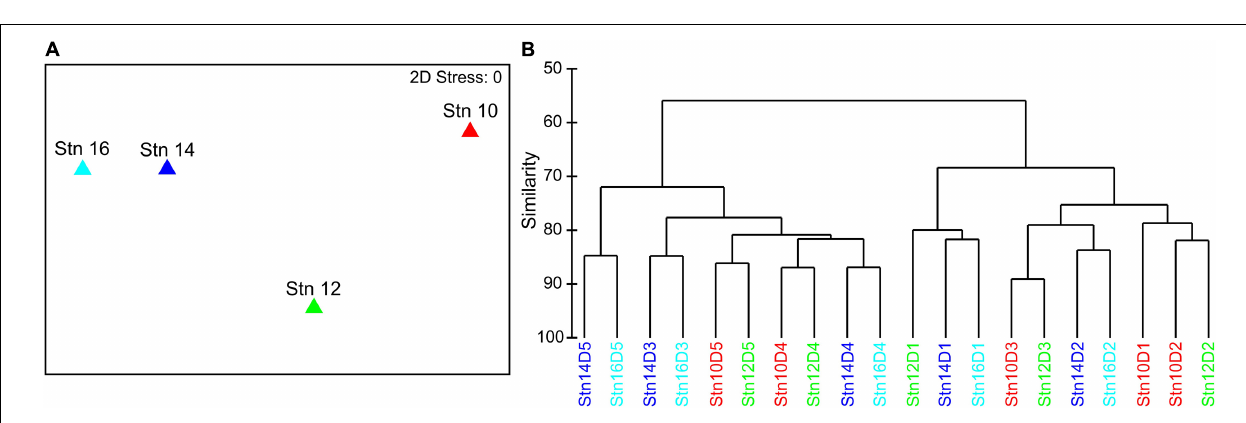
FIGURE 3 | (A) Non-metric multidimensional scaling (nMDS) plot of the four stations across the filament based on a Bray–Curtis dissimilarity matrix of log( x + 1) transformed total abundances of all species at each station. (B) Hierarchical cluster analysis based on a Bray–Curtis dissimilarity matrix of log( x + 1) transformed depth-specific species abundances at each station. D1: 0–10 m, D2: 10–50 m, D3: 50–100 m, D4: 100–200 m, D5: 200–300